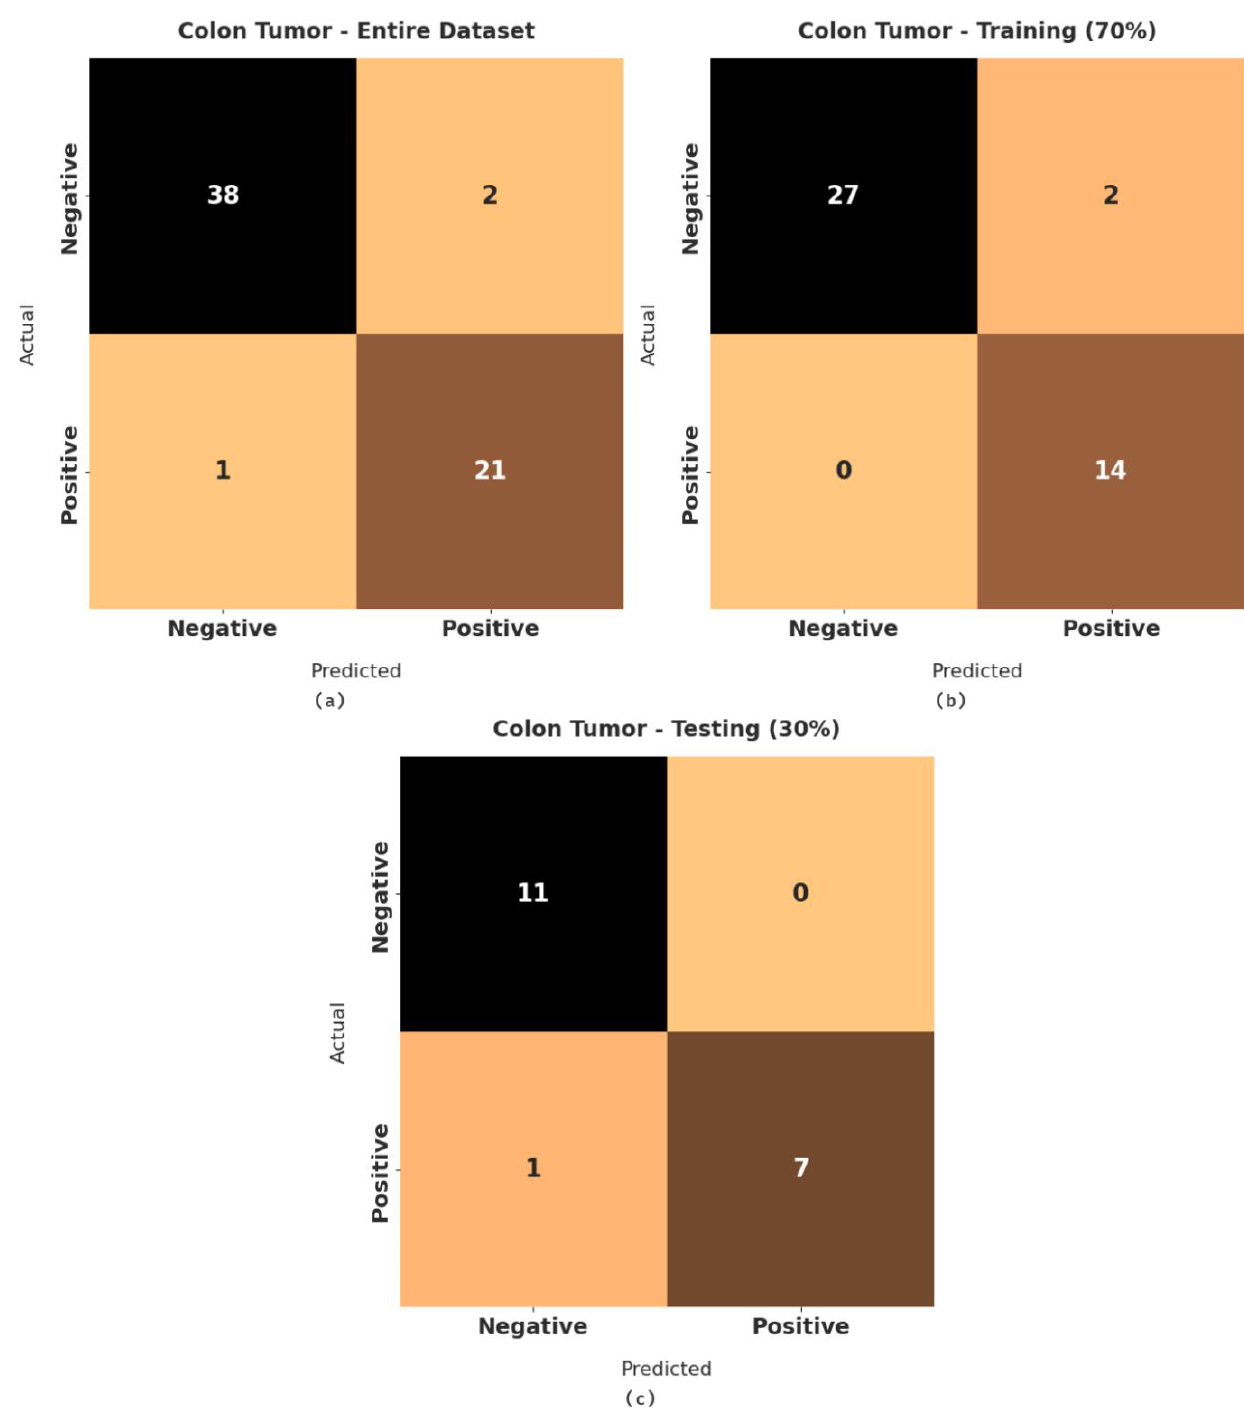
Figure 6. Confusion matrices of RFODL-MGEC technique on colon tumor dataset. ( a ) Entire dataset, ( b ) 70% of training dataset, and ( c ) 30% of testing datase